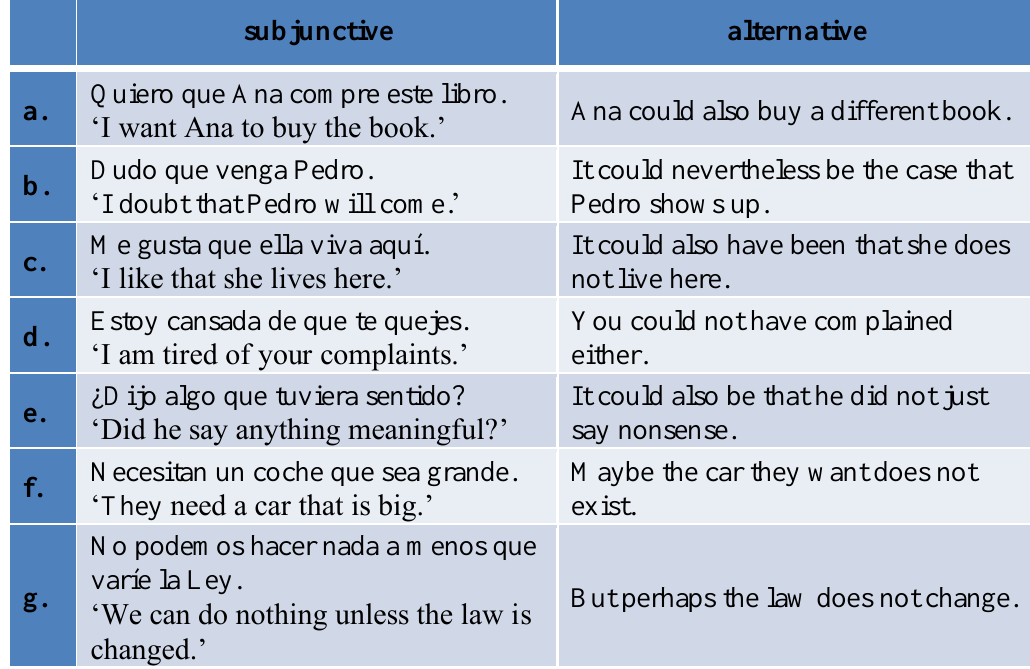
Table 1. Illustration of that practical approach to teaching the